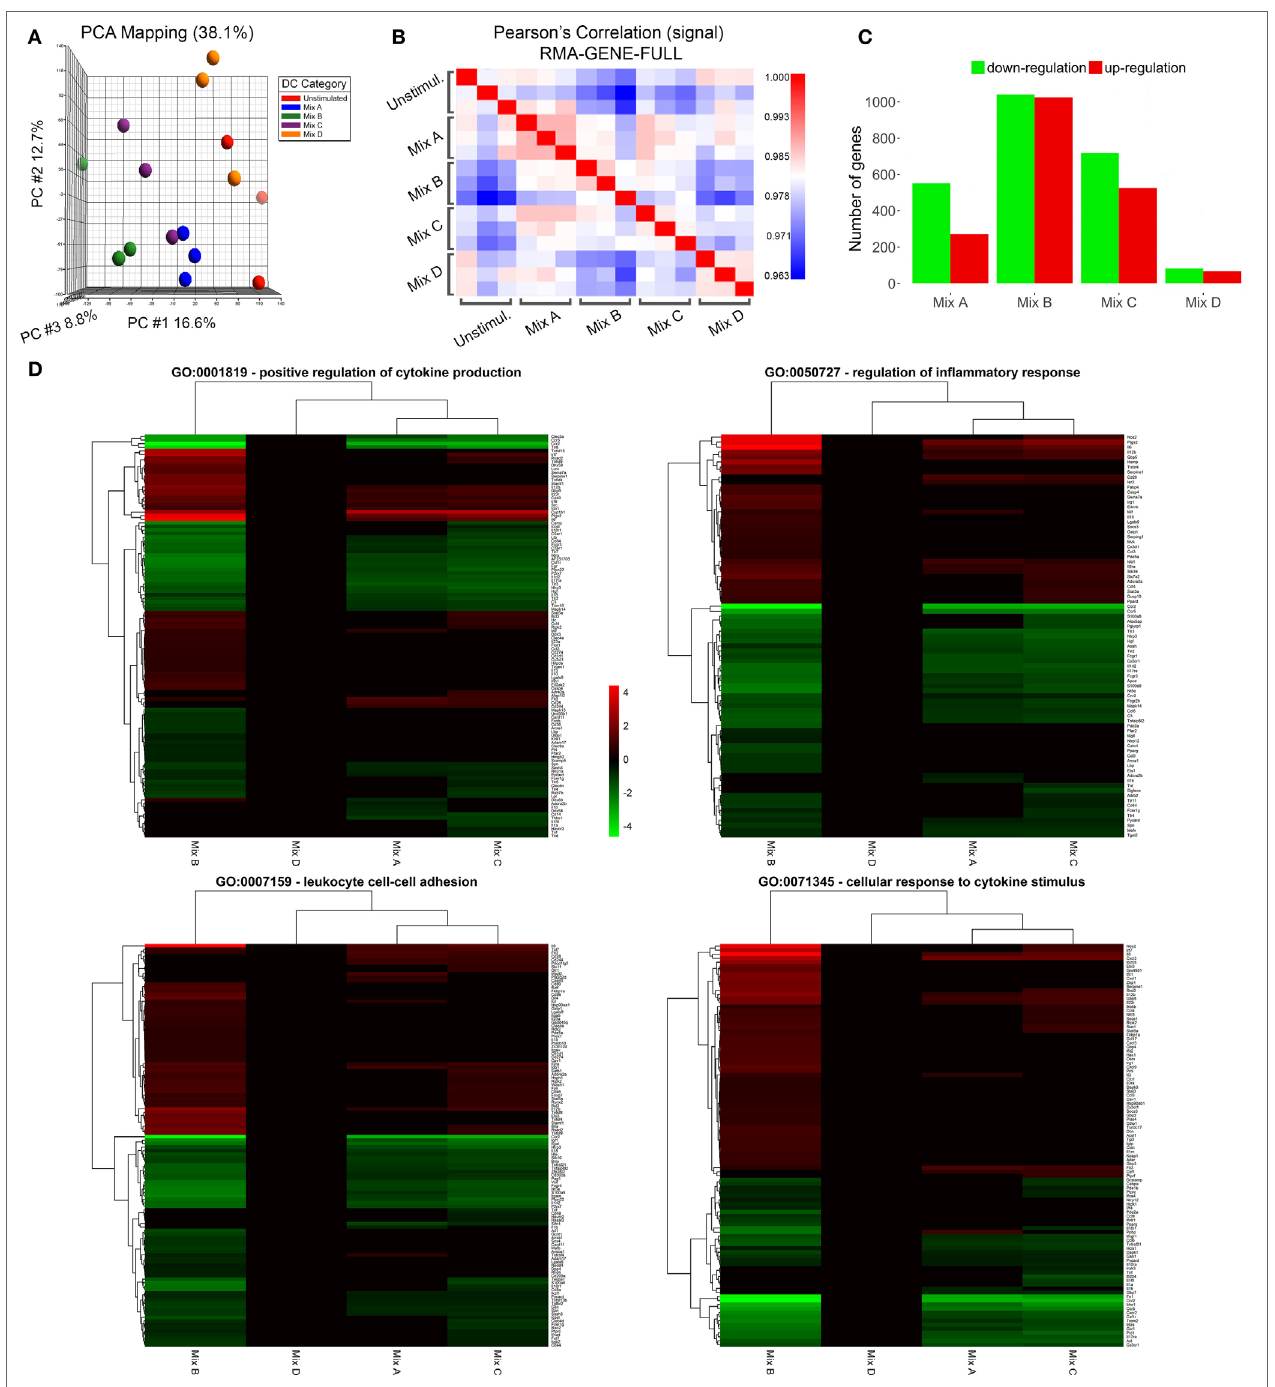
FigUre 8 | Microarray sample quality control and differential expression analysis. (a) Principal component analysis clustering of microarray samples and (B) sample-sample correlation heat map depicting relationship between replicates and/or samples. (c) Barplot of differentially up- and downregulated genes of dendritic cells (DCs) stimulated with the mix of poly(lactic- co -glycolic) acid (PLGA)-chCPAp, PLGA-chH1p, and PLGA-KMP-11p nanoformulations (mix A), the mix of PLGA-chCPAp-monophosphoryl lipid A (MPLA), PLGA-chH1p-MPLA, and PLGA-KMP-11p-MPLA nanoformulations (mix B), the mix of p8-PLGA-chCPAp, p8-PLGA-chH1p, and p8-PLGA-KMP-11p nanoformulations (mix C), or the mix of soluble chimeric peptides (mix D) vs. unstimulated DCs. (D) Heatmap representations of differentially expressed genes included in GO terms GO:0001819—positive regulation of cytokine production, GO:0050727—regulation of inflammatory response, GO:0007159—leukocyte cell–cell adhesion and GO:0071345—cellular response to cytokine stimulus. Instances with − 0.585 < log2(fold change) < 0.585 and/or p -value > 0.05 significance threshold are not colored. A p -value threshold of 0.05 and a log2 (fold change) threshold of ± 0.585 (at least1.5-fold change) was used to determine differentially expressed genes of samples Mix A–D vs. unstimulated